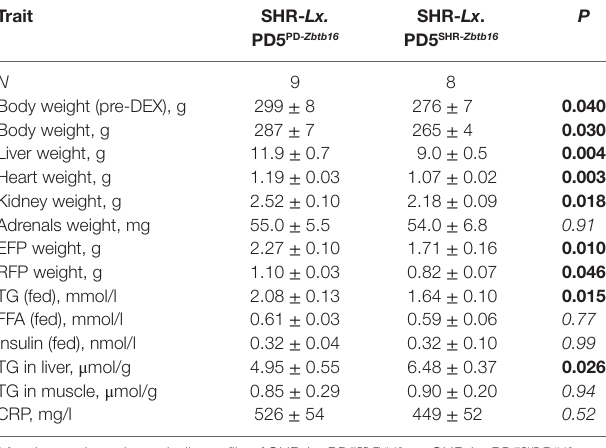
TaBle 1 | Morphometric and metabolic profile of the congenic rat strains. Trait